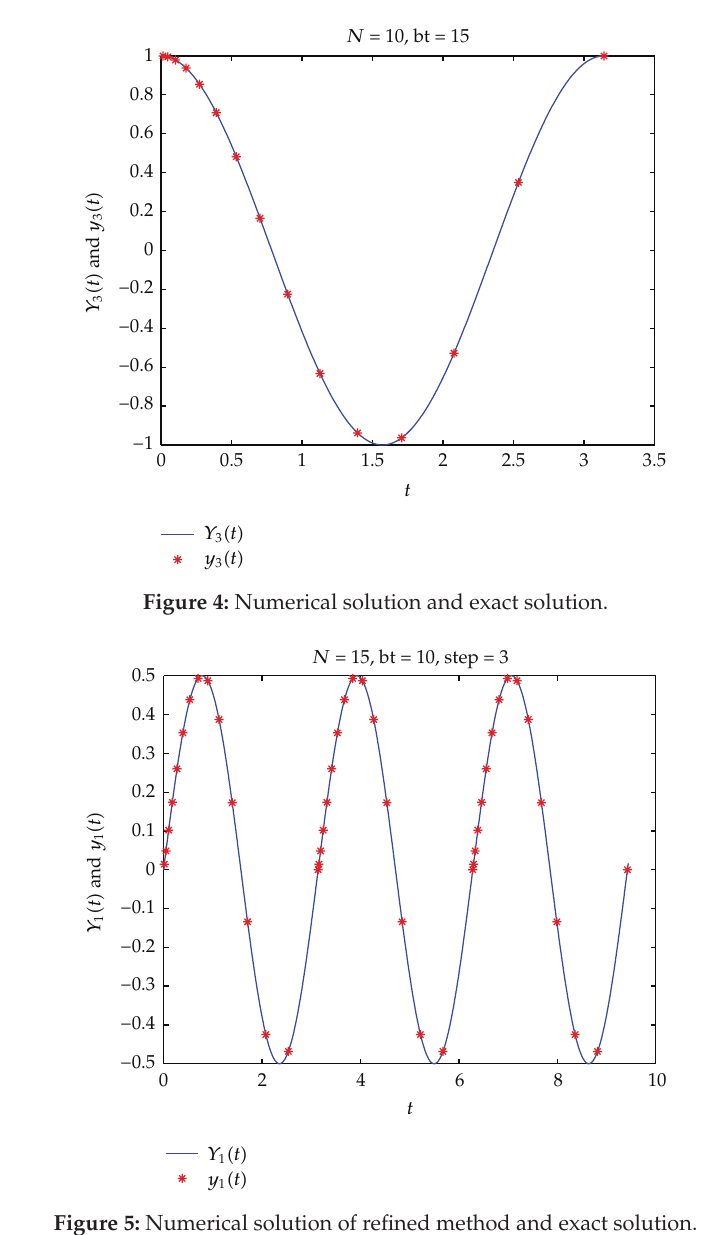
Figure 5: Numerical solution of refined method and exact